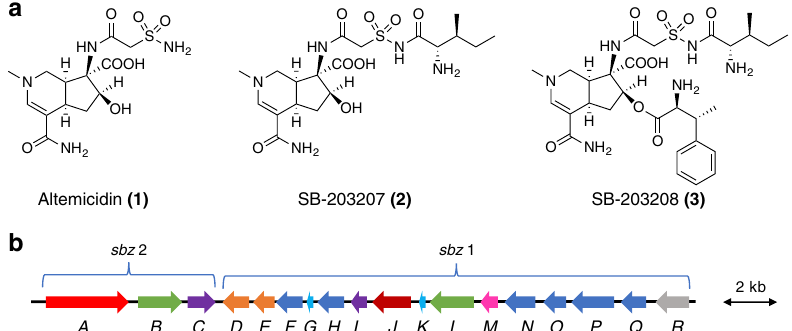
Fig. 1 Chemical structure of the aminoacyl sulfonamide antibiotics and the gene organization of sbz cluster. a Structures of the aminoacyl sulfonamide antibiotics and b the organization of the sbz cluster (Please see Supplementary Table 1 for